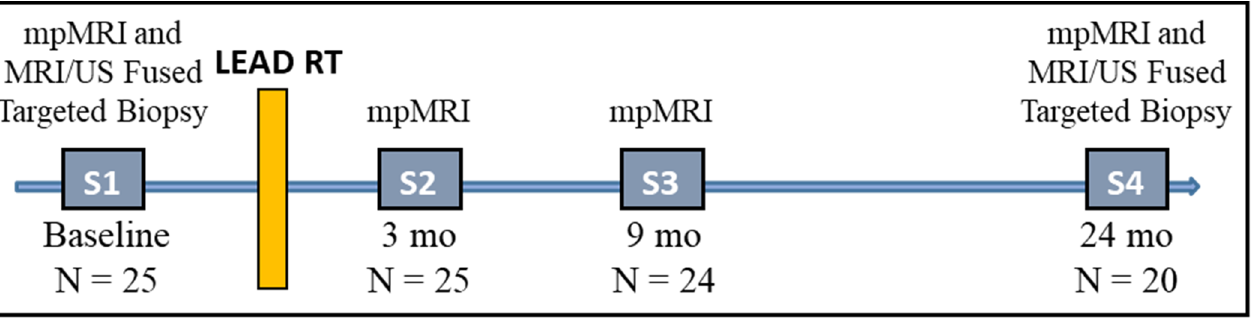
Figure 1. Timeline of mpMRI and biopsy acquisition. At each time point the number of analyzed patients is shown. Post-RT series were acquired at 3-, 9-, and 24-months after end of